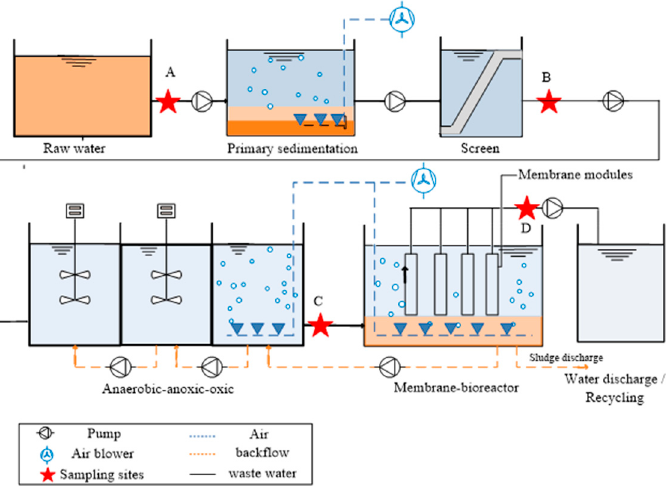
Figure 1. Flowchart of treatment process in the WWTP and sampling scheme (( A ) Influent; ( B ) AGC effluent; ( C ) AAO effluent; ( D ) MBR effluent). effluent; ( C ) AAO effluent; ( D ) MBR